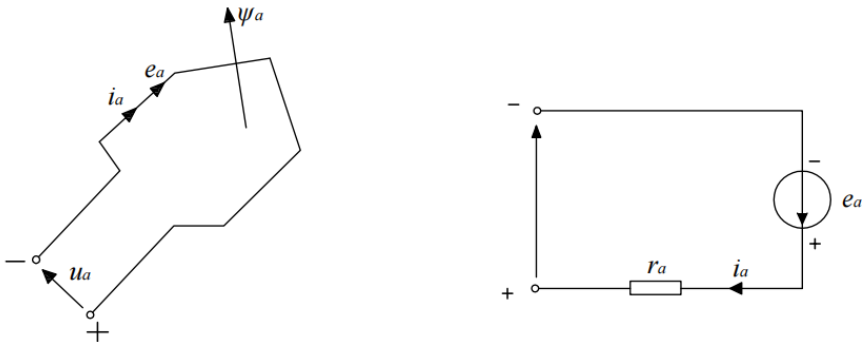
direction of T e is opposite to the positive direction of the speed, and the positive direction of the mechanical torque T L input from the shaft is consistent with positive direction of the speed [31]. The conventional positive direction of permanent magnet generator is shown in Figure 2. According to the above assumptions, the structure model of permanent magnet synchronous generator is established, it is shown in Figure 3.